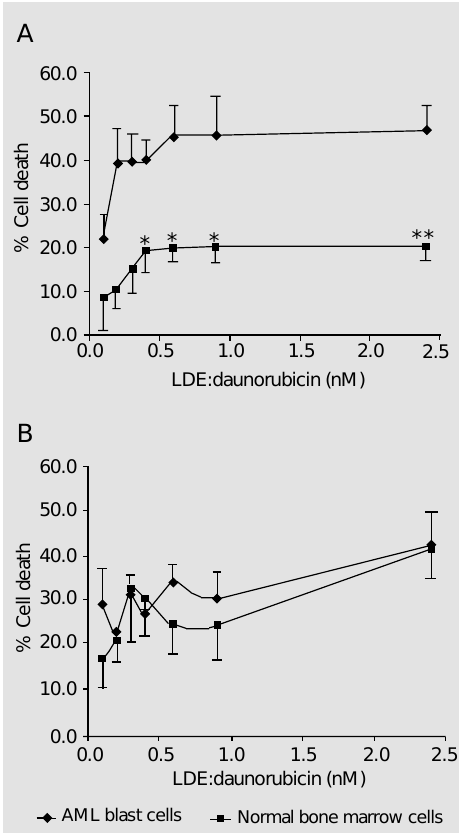
Figure 3. A , Cytotoxicity of the LDE:daunorubicin complex against normal bone marrow cells (squares) and acute mye- logenous leukemia (AML) blast cells (lozenges). The points rep- resent the mean ± SEM of 7-15 experiments. *P<0.05 and **P<0.001 compared to normal bone marrow cells (Student t - test). B , Cytotoxicity of free dau- norubicin against normal bone marrow cells (squares) and AML blast cells (lozenges). The points represent the mean ± SEM of 7- 17